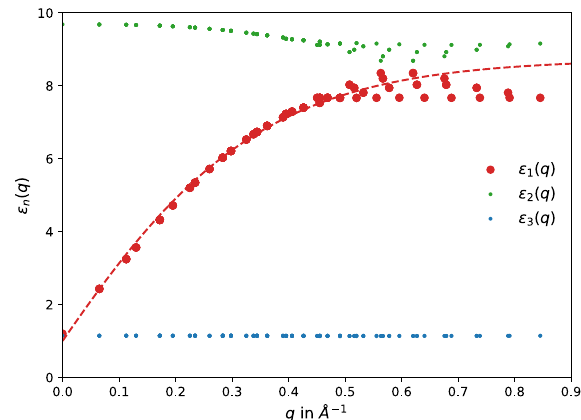
Fig. 6 Leading screening channels in the Wannier function continuum electrostatics approach. Red, green, and blue dots correspond to ε 1 ( q ), ε 2 ( q ), and ε 3 ( q ), respectively. ε 1 ( q ) is fi tted using the expression from Eq. (25). The shown data is for the ( d + p